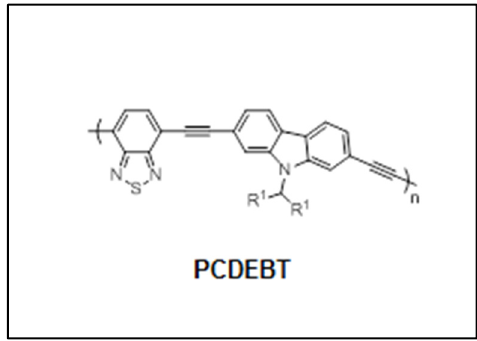
Figure 24. Molecular structure of PCDEBT.